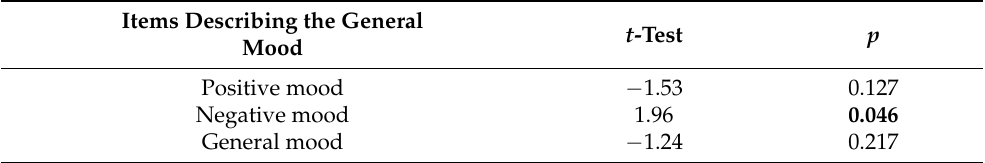
Table 5. Differences between mean values for the General Mood Scale obtained in the group of inmates who were (N = 109) and were not infected with SARS-CoV-2 (N = 141). Items Describing the General t -Test p Mood Positive mood − 1.53 0.127 Negative mood 1.96 0.046 General mood − 1.24 0.217 Bold font means that result is significant at the level of statistical significance.